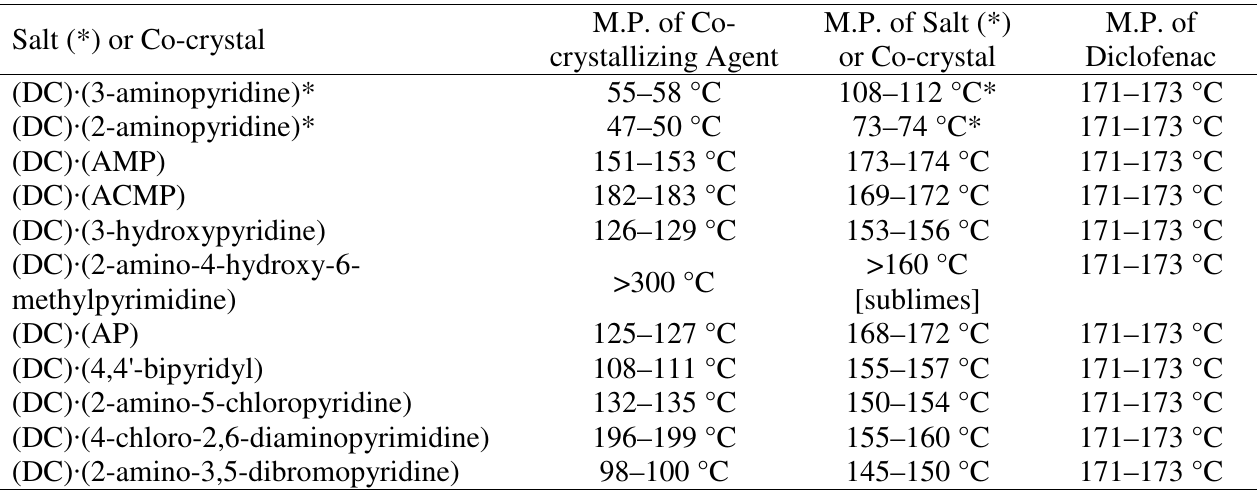
Figure 4. (a) co-crystal of diclofenac and 2-amino-5-methyl-1,3-thiazolium (DC) ·